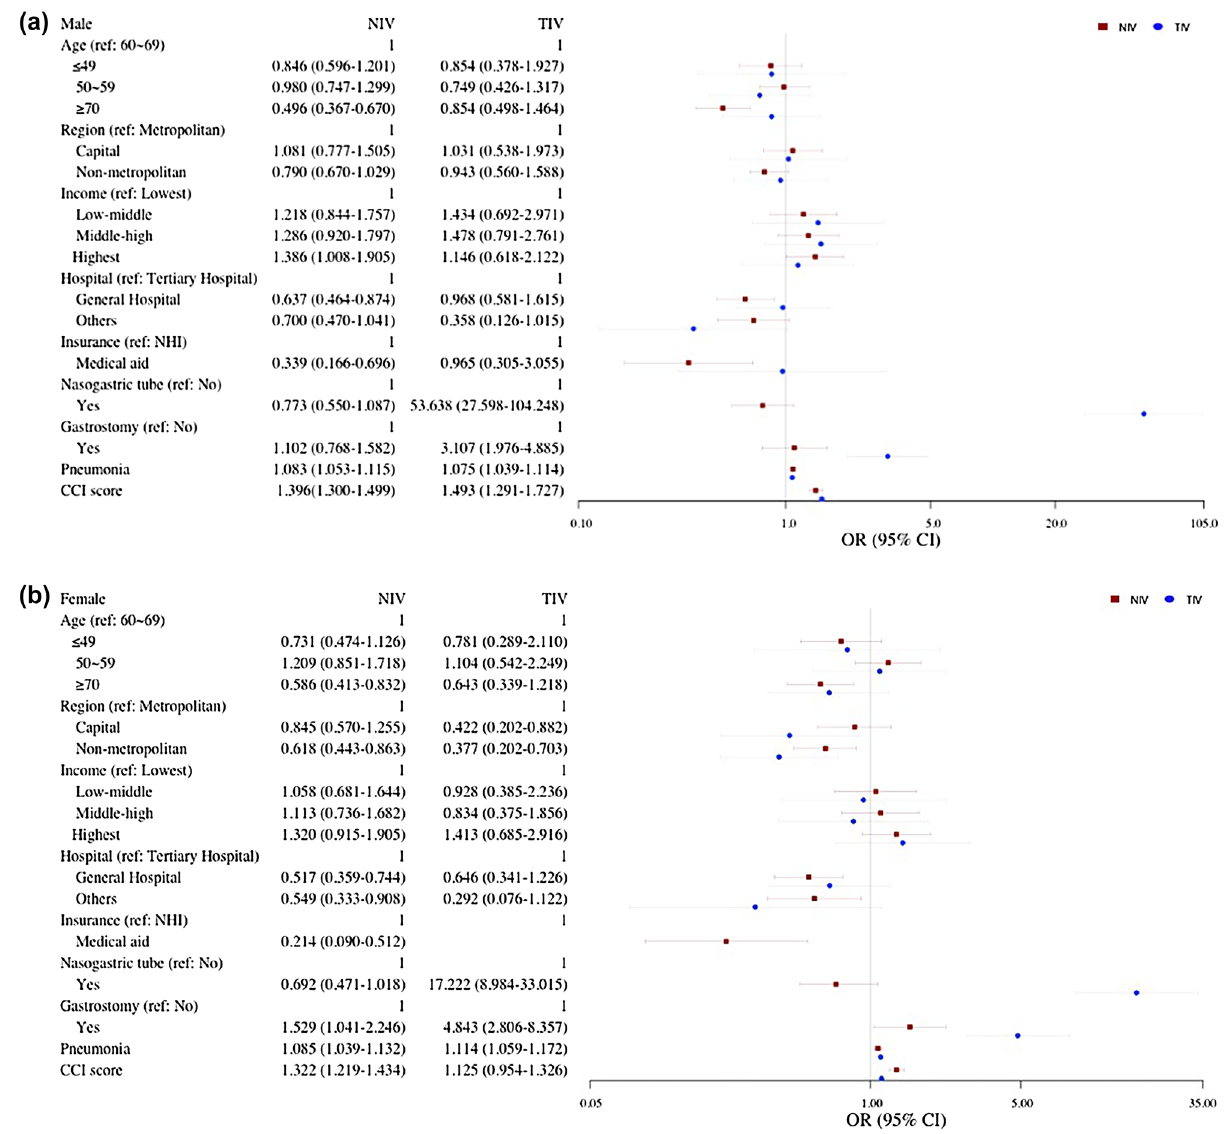
Figure 2. Adjusted odds ratio for assisted ventilation according to type of ventilation in ( a ) males and ( b ) females with amyotrophic lateral